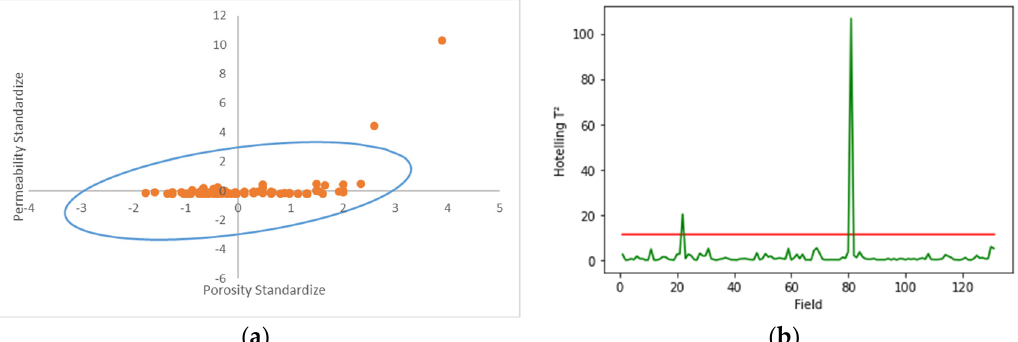
Figure 10. ( a ) Simultaneous boundary ellipse and ( b ) the Hotelling T 2 chart for miscible CO 2 -EOR simultaneous screening model B.